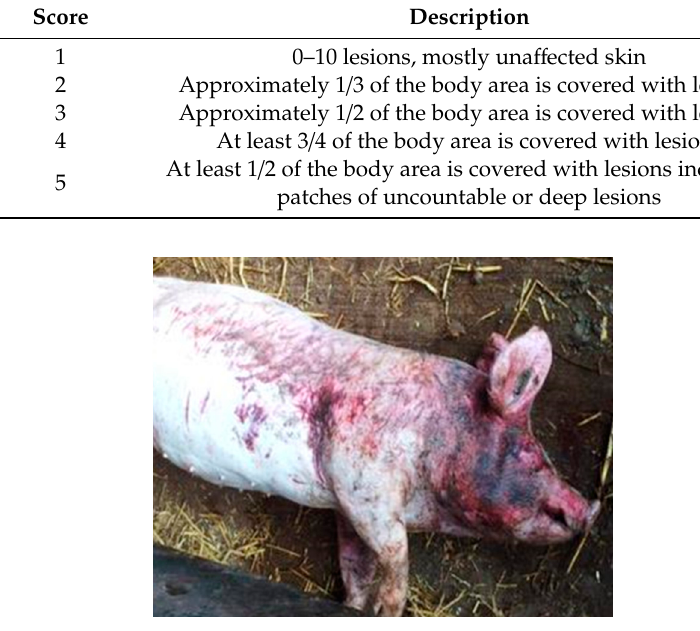
Figure 1. Extreme patches of skin lesions on the body, predominantly in the face, of a dead victim.